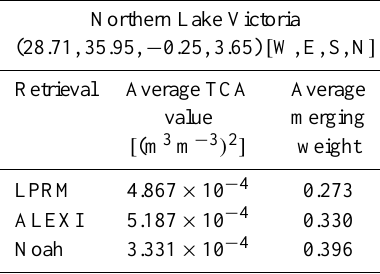
Fig. 12. Comparison of anomalies from individual and merged products using a January 2007–June 2010 baseline, averaged over the area of interest within the Horn of Africa (see Fig. 1).